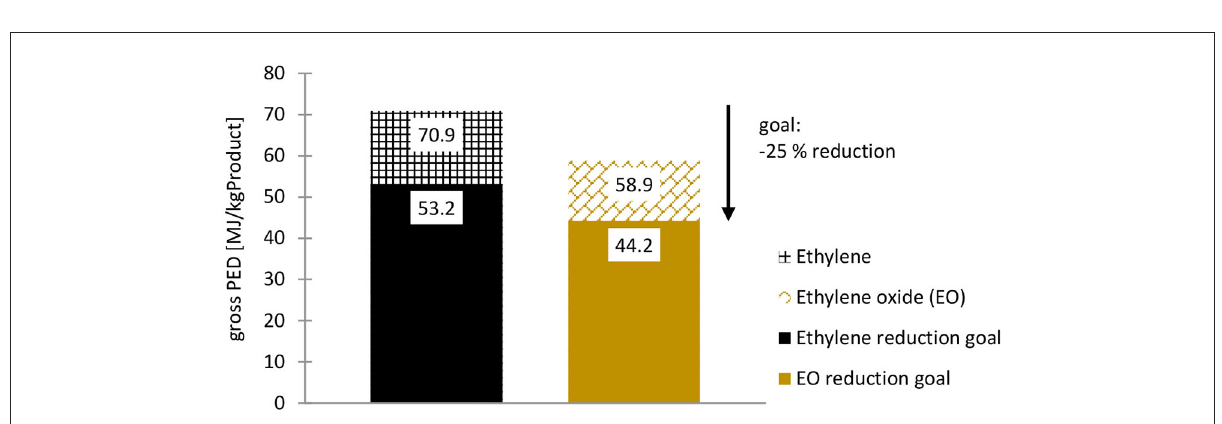
FIGURE2 PED of fossil-based ethylene and EO in Germany: Current PED and reduction goal for 1kg fossil-based ethylene (GaBi sphera, 2020c) and EO (GaBi sphera, 2020g) produced. Source: Own illustration based on LCA data from GaBi sphera.